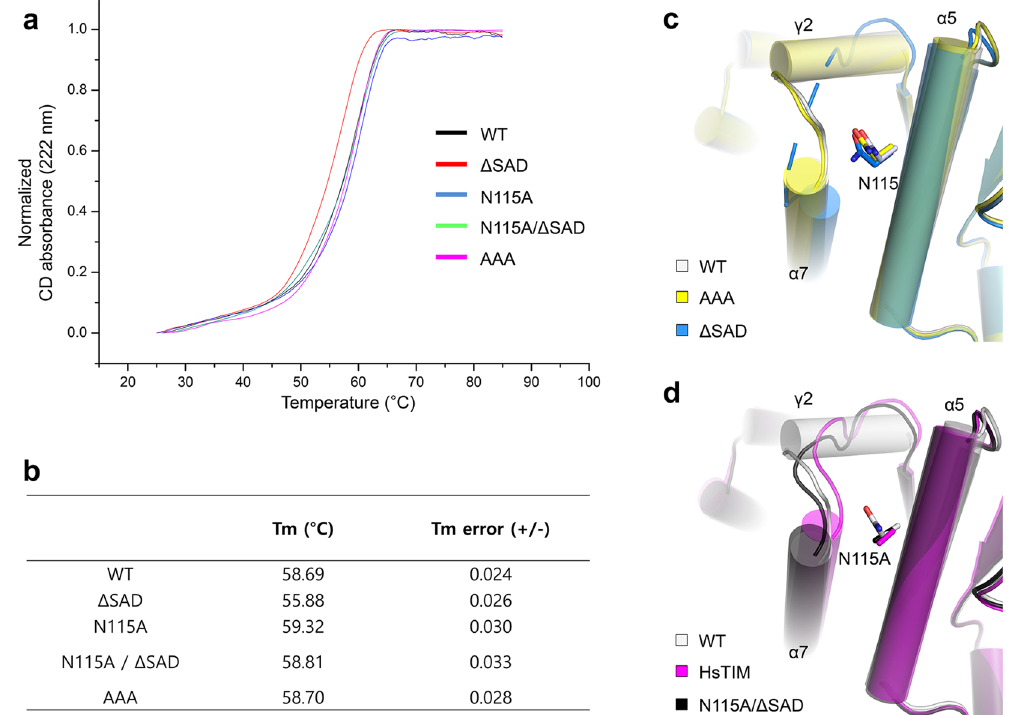
Figure 3. Thermostability of OvTIM and variants and comparative analysis. ( a ) Thermal stability of wild-type and variants (AAA, ∆ SAD, N115A, and N115A_ ∆ SAD). ( b ) Melting temperature of variants based on the CD absorbance at 222 nm. ( c ) Superimposition of wild-type, AAA, and ∆ SAD variant structures. N115 residues from wild-type, AAA, and ∆ SAD are represented as a stick model. The disordered region of ∆ SAD variant is represented as a dash. ( b ) Superimposition of the OvTIM, HsTIM, and ∆ SAD_N115A